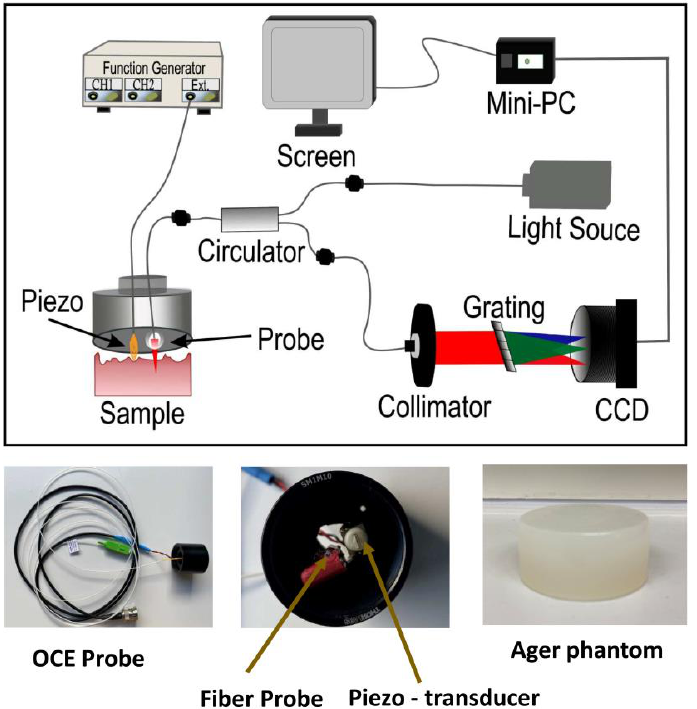
Figure 1. Schematic of the SD-OCE system. The lower panel on the left shows the fiber-based probe, the middle shows the tip of the probe with optical fiber and piezoelectric transducer, and the right panel shows one of the ager phantoms.